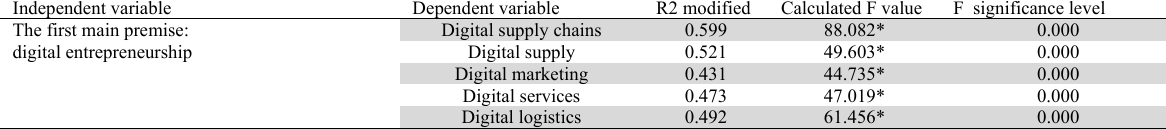
The results of the analysis of variance to ensure the validity of the model to test the hypotheses of the study Independent variable digital entrepreneurship